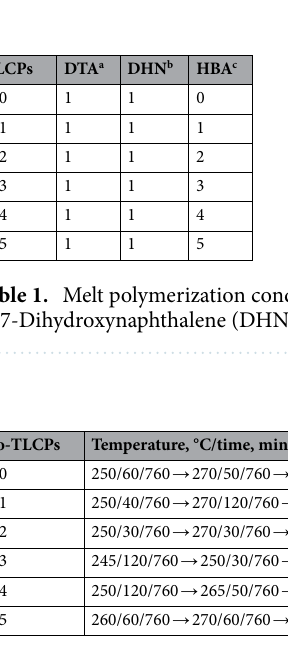
Table 2. Melt polymerization conditions of Co-TLCPs.